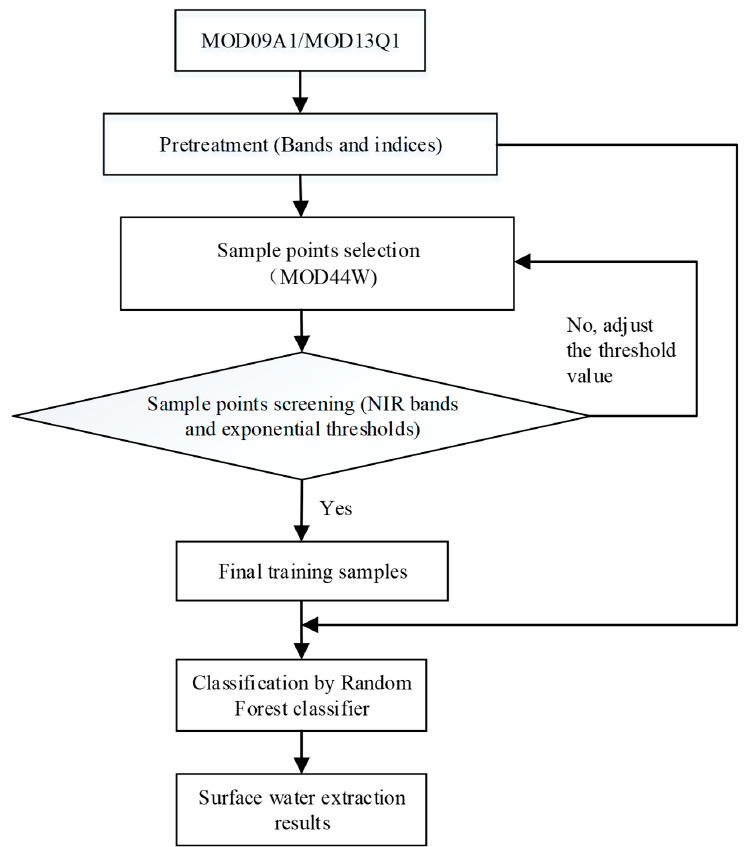
Figure 3. Surface water extraction process for MOD09A1 and MOD13Q1.